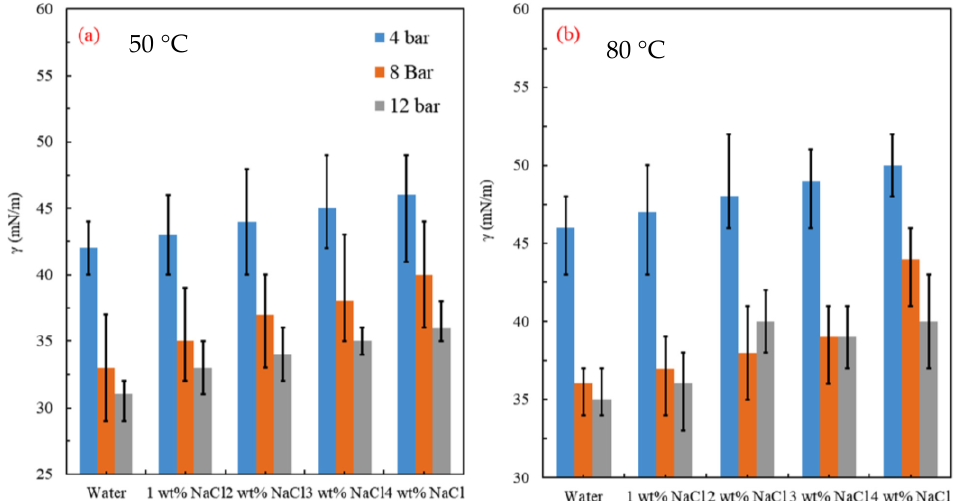
2 wt% NaCl) in conjunction with CO 2 injection to improve oil recovery [8].